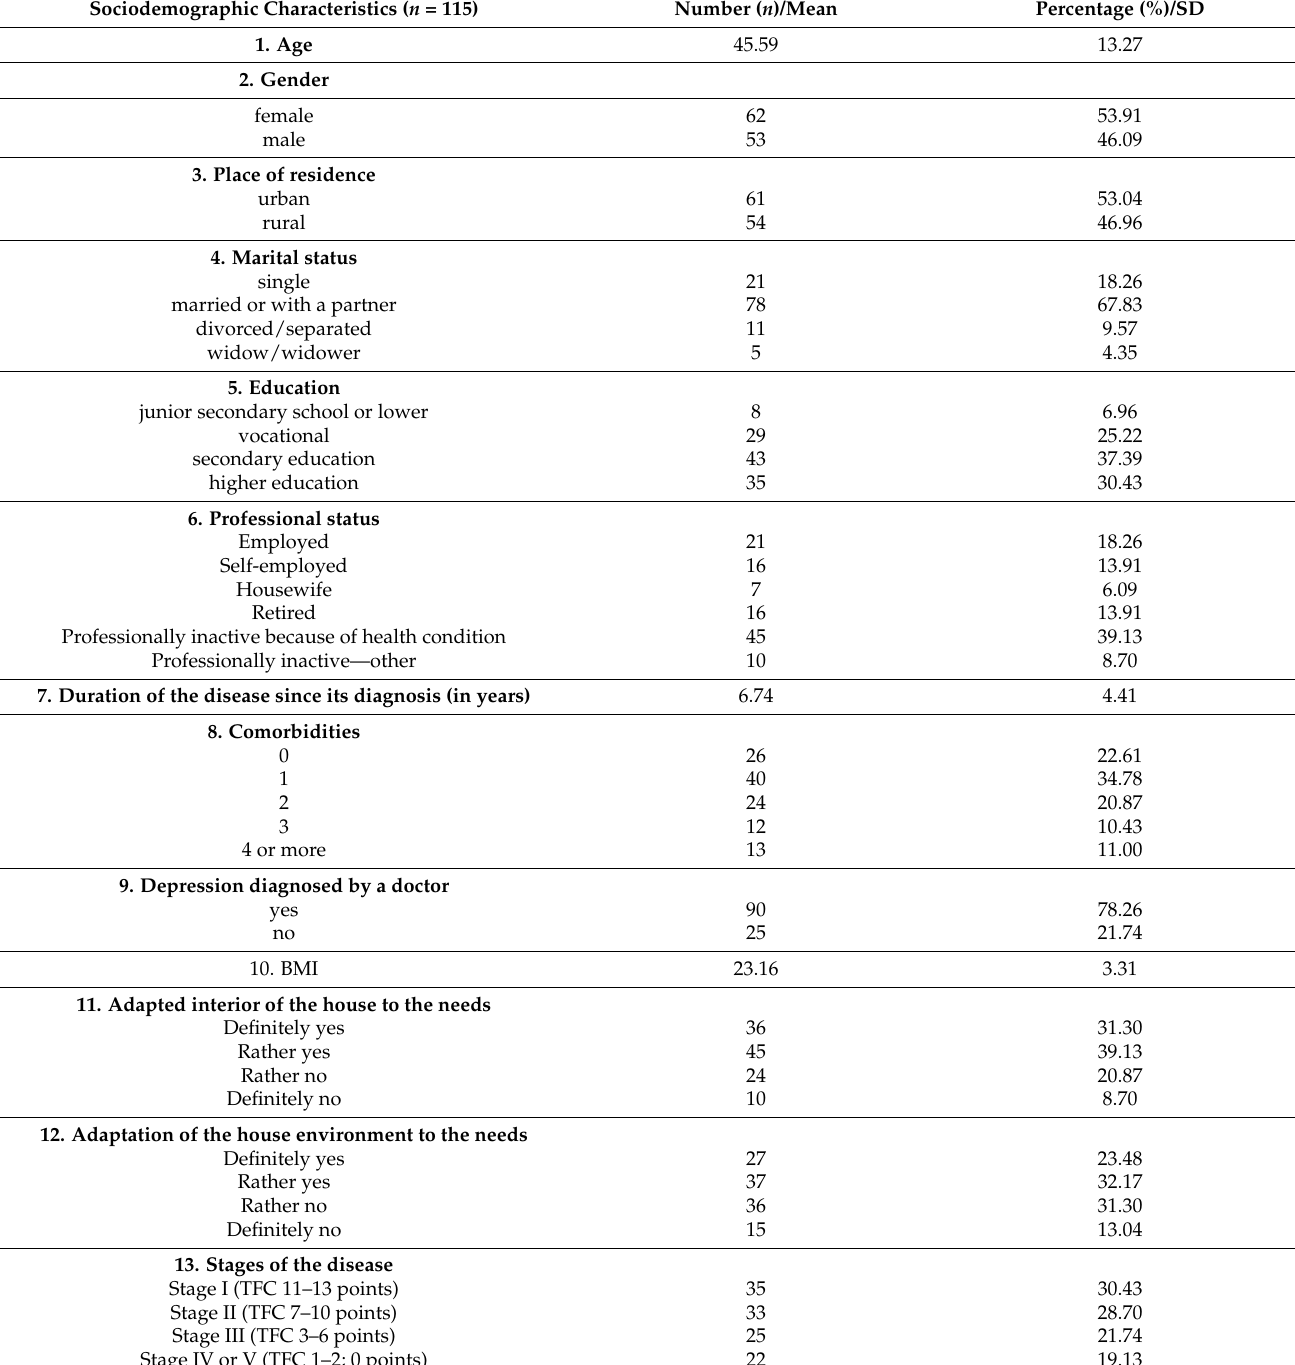
Table 1. General sociodemographic characteristics of the studied